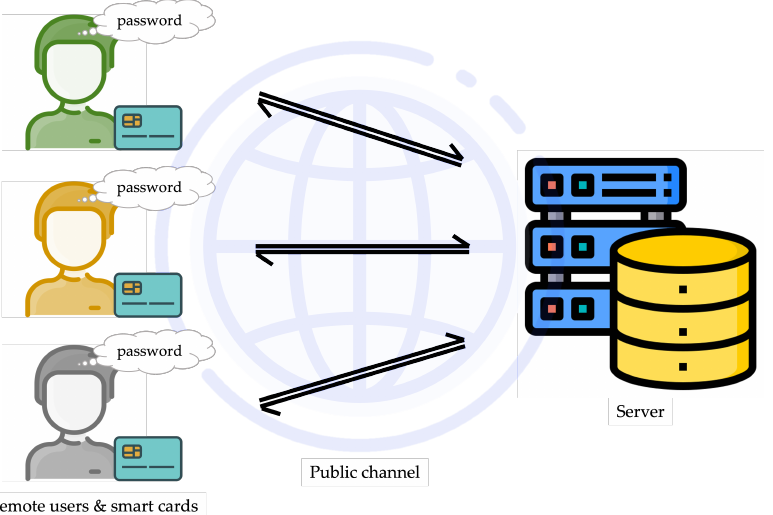
Figure 1. Architecture of two-factor remote authentication with multiple users and a single